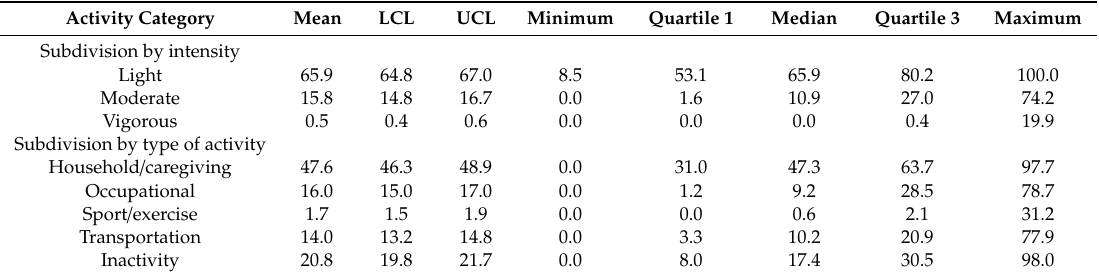
Table 3. Contribution of each type activity to the total activity